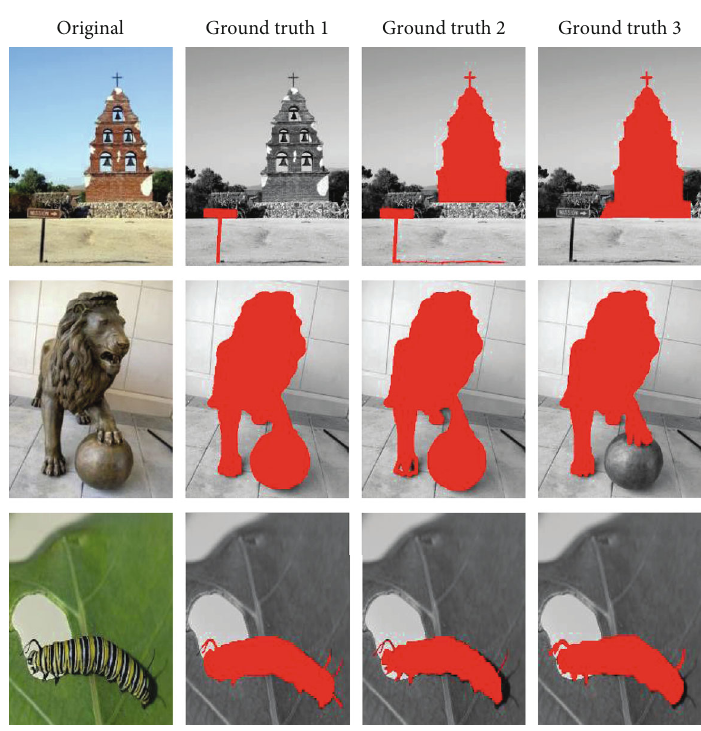
Figure 4: Images and their ground